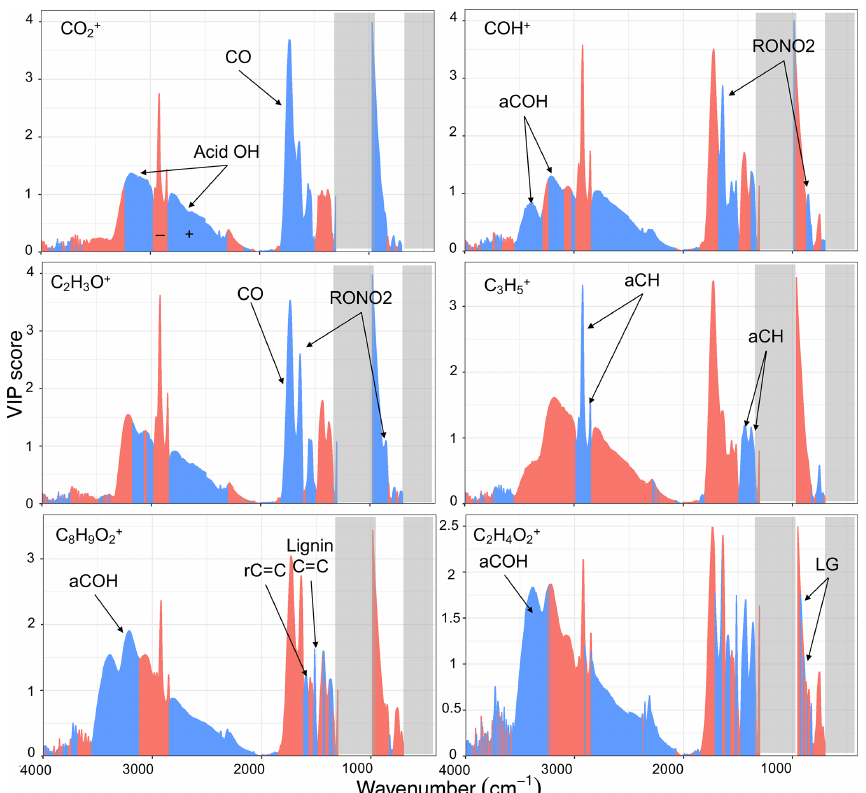
Figure 7. VIP scores of MIR absorbances regressed against AMS fragment ion concentrations (averaged over the filter sampling periods). Blue and red scores correspond to wavenumbers with positive and negative regression coefficients in the PLSR models, respectively. Impor- tant functional groups for each mass fragment are indicated, and PTFE absorption regions are masked by gray